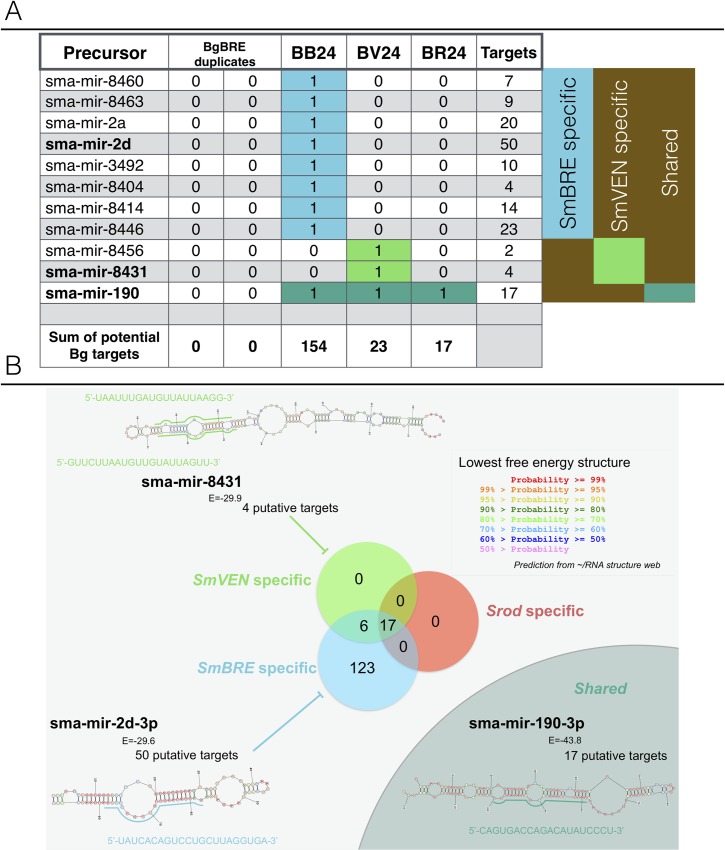
In-silico identification of parasite miRNAs.miRNAs were assessed using libraries obtained from naïve snails and snails infected for 24 h under the various interaction conditions (BB24, BgBRE x SmBRE; BV24, BgBRE x SmVEN; BR24, BgBRE x Srod). A) Table highlighting the precursor miRNAs that may have targets among the immune-related snail transcripts selected in the present work. They include eight precursors specifically recovered in BB24, two in BV24, and one shared across the three infected conditions. The total numbers of potential targets in each condition are indicated. B) Venn diagram showing the potential targets according to the sympatric or allopatric interactions. Shown is an example miRNA stem-loop precursor that presents the highest number of potential host targets.